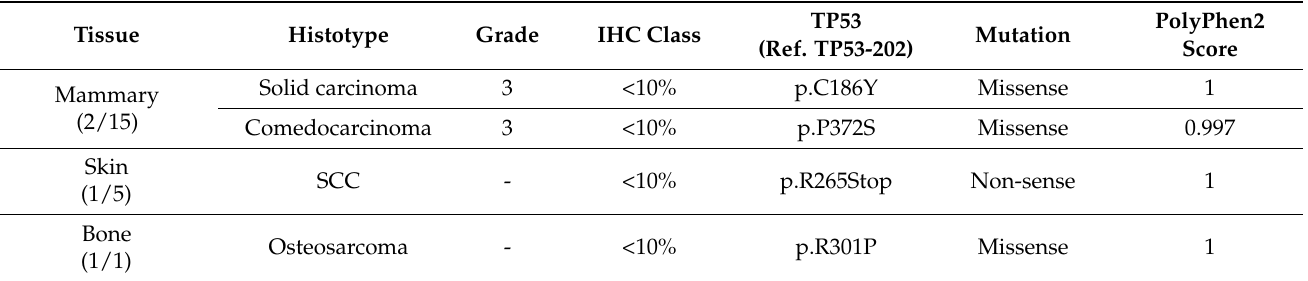
Table 2. p53-negative tumors with <10% positive cells. Only the four cases with TP53 mutations are reported (4/26). SCC, squamous cell carcinoma.